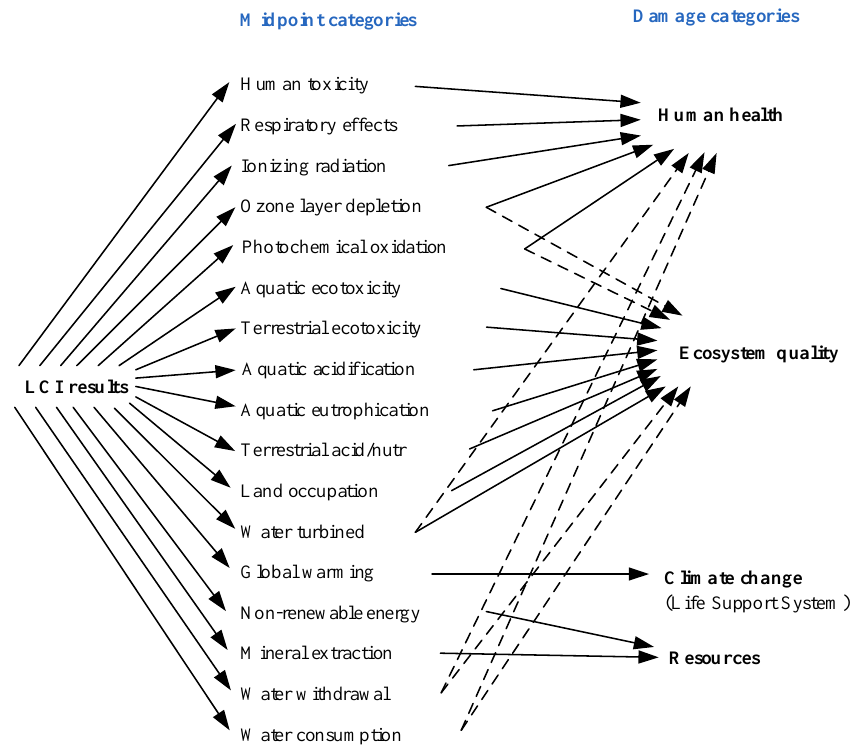
Fig. 5. Concept of IMPACT 2002+: linking LCI via the midpoint categories to four damage categories